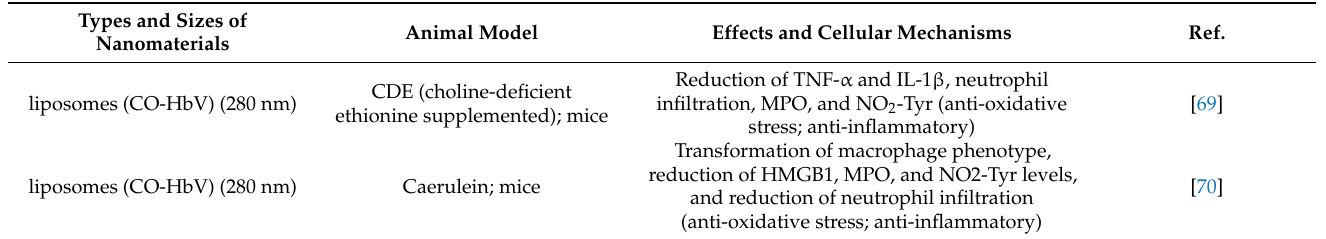
Figure 6. Se@SiO 2 nanoparticles can reduce pancreatic oxidative stress in mice with cerulein-induced AP. ( A ) Immunofluorescence staining of ROS produced in pancreatic tissue (red: ROS; blue: nucleus). ( B ) The relative number of ROS-positive cells in each group. ( C ) Myeloperoxidase (MPO) staining results of pancreatic samples from each treatment group (green: MPO; blue: nuclei). ( D ) The relative number of MPO-positive cells in each group. p < 0.05 vs *the CON group, #the CAE group, and $the CAE + 1 mg/kg Se@SiO 2 group. Reprinted from [120]. Copyright 2021, with permission from John Wiley & Sons, Inc. Table 2. Different types of nanomaterials used for the treatment of acute pancreatitis.